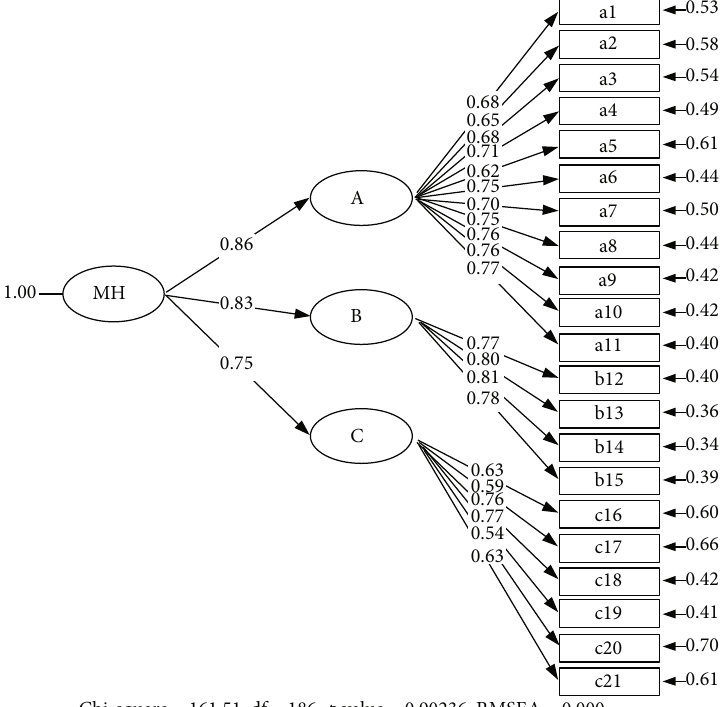
Figure 2: The second-order CFA of resilience